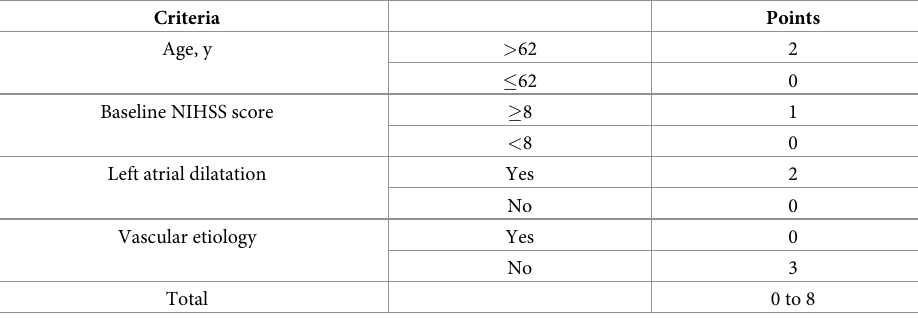
Table 1. Criteria and scoring for the STAF